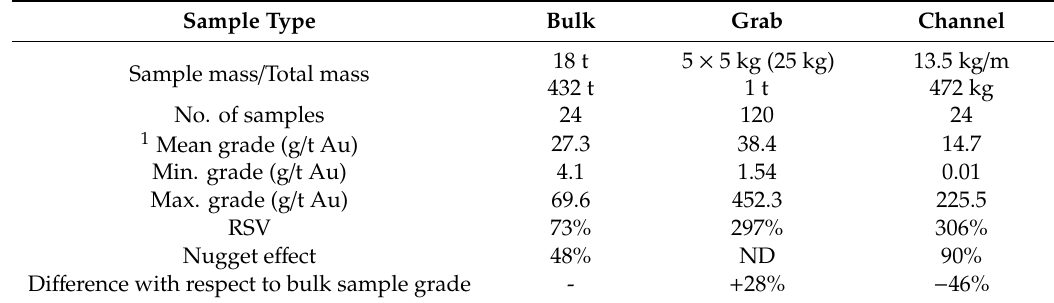
Table 19. Comparison of samples along the Veta Christina South 2 level drive.